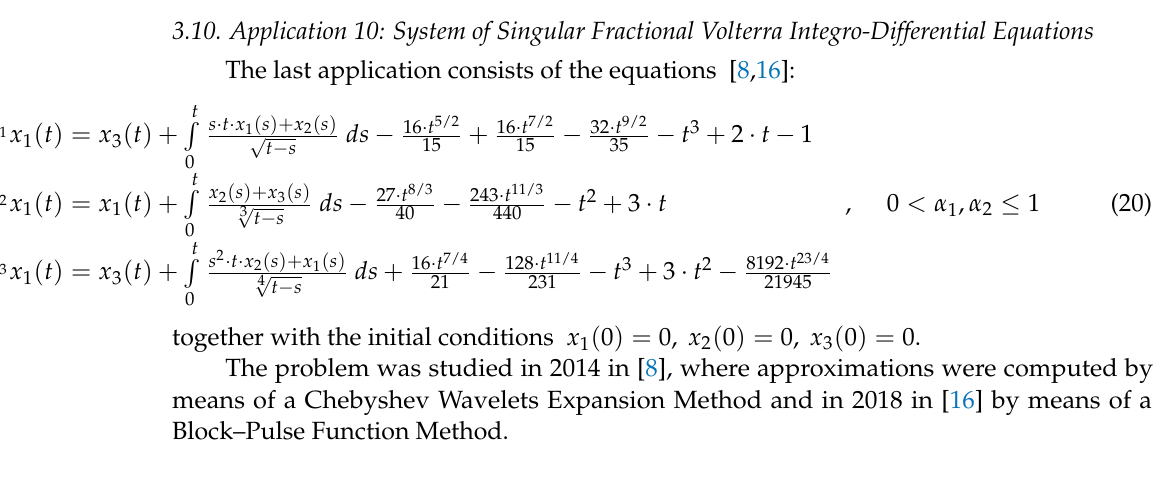
Figure 6. Approximate solutions x 2 of (19) for several values of α 1 and α 2